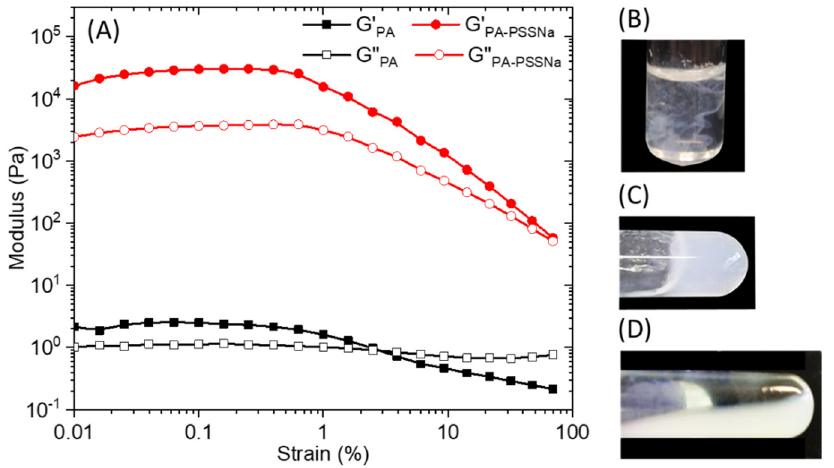
Figure 5. ( A ) Storage (G’) and loss (G’’) modulus of a 10 wt.% solution of C 16 V 3 A 3 K 3 G-NH 2 (black) or C 16 V 3 A 3 K 3 G-NH 2 —PSSNa (red) in water as a function of strain at a constant frequency of 10 rad/s. Aqueous solution mixture between C 16 -V 3 A 3 K 3 G-NH 2 (15 mg in 0.5 mL mQ water) and PSSNa (6 mg in 0.5 mL mQ water) (R +/ − = 1) just after complete addition ( B ), after slight hand stirring ( C ), and after vortexing ( D ).